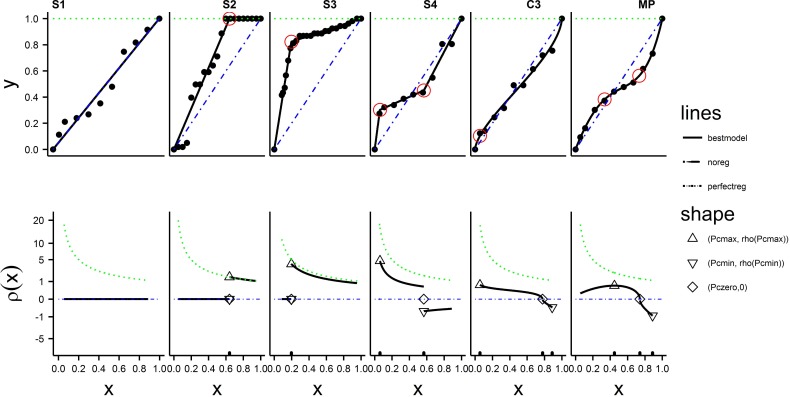
Hypoxia plots (top panels) and matched regulation profiles (bottom panels) for a selected animals with best fitting models S1,S2,S3,S4,C3, and MP. Solid black lines (──) are the predicted lines for y and ρ(x). Observed data points are marked with black dots. The alternating dot-dash blue line (— · — · — ·) is the expected line for a non-regulator for both y and ρ(x). The dotted green line (····) is the expected line for a perfect regulator for both y and ρ(x). In the hypoxia plot threshold points are marked by a red circle. In the regulation profile points with x values at Pc-min, Pc-zero and Pc-max, are marked with ▽, ◊ and Δ, respectively, and their locations on the x-axis are marked with tics just above the axis.